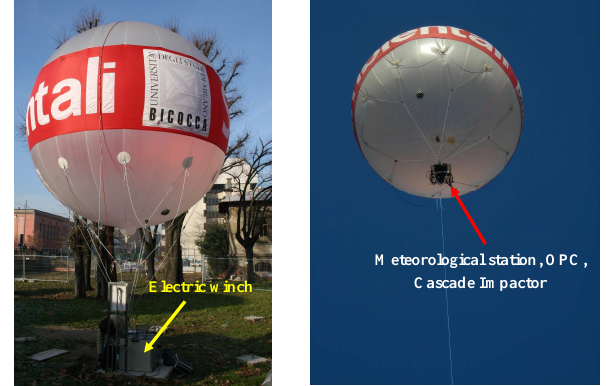
Fig. 1. The tethered balloon and the electric winch at the sampling site, and the balloon during a flight with its